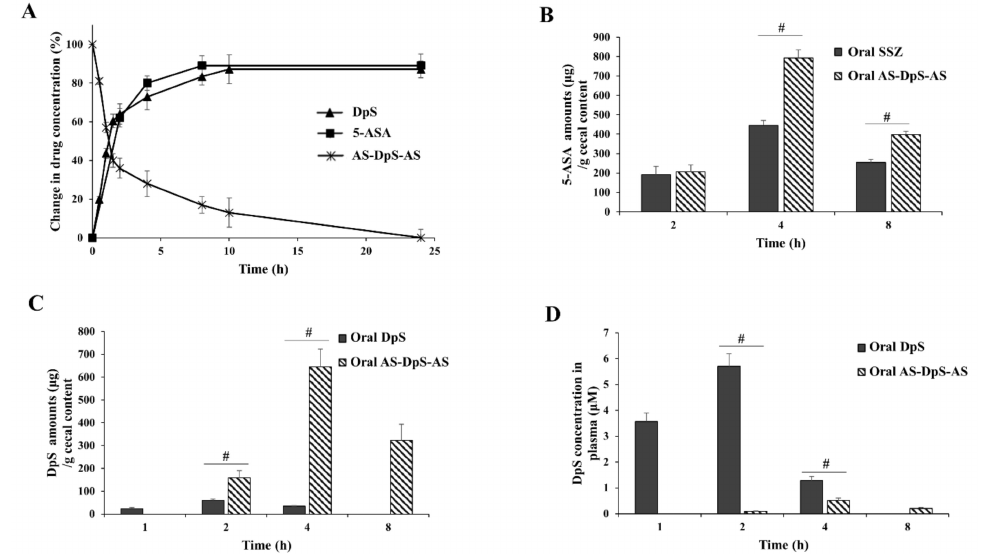
Figure 2. AS-DpS-AS is a colon-specific prodrug activated to DpS and two molecules of 5-ASA: ( A ) AS-DpS-AS (1.0 mM) were incubated in cecal contents suspended in pH 6.8 PBS (10%) under N 2 atmosphere. The concentration of drugs was analyzed by HPLC at appropriate time intervals. The data represent mean ± SD (n = 3). Male SD rats (250–260 g) were allowed to fast for 24 h except for drinking water. ( B ) AS-DpS-AS (34 mg/kg, equivalent to 50 mg/kg of SSZ) or SSZ (50 mg/kg) suspended in pH 7.4 PBS was administered to rats via oral gavage. The rats were sacrificed at 2, 4, and 8 h after oral gavage, and concentrations of 5-ASA in the cecum were measured by HPLC. # p < 0.05. ( C ) DpS (15 mg/kg) or AS-DpS-AS (34 mg/kg, equivalent to 15 mg/kg of DpS) suspended in pH 7.4 PBS was administered to rats via oral gavage. The rats were sacrificed at 1, 2, and 4 h (for oral DpS) or 2, 4, and 8 h (for oral AS-DpS-AS) after oral gavage, and concentrations of DpS in the cecum were measured by HPLC. # p < 0.05. ( D ) Simultaneously, blood samples were obtained by cardiac puncture. DpS was analyzed in the blood by using HPLC. The data represent mean ± SD (n = 5). # p <